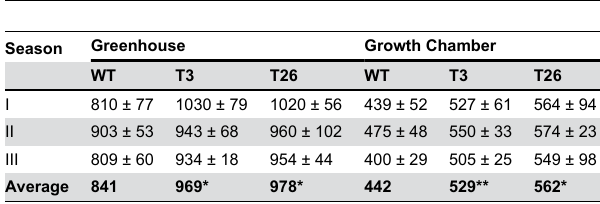
Table 1. Tuber yield (g/pot) of wild-type (WT) and MsrA3 transgenic plants (T3,